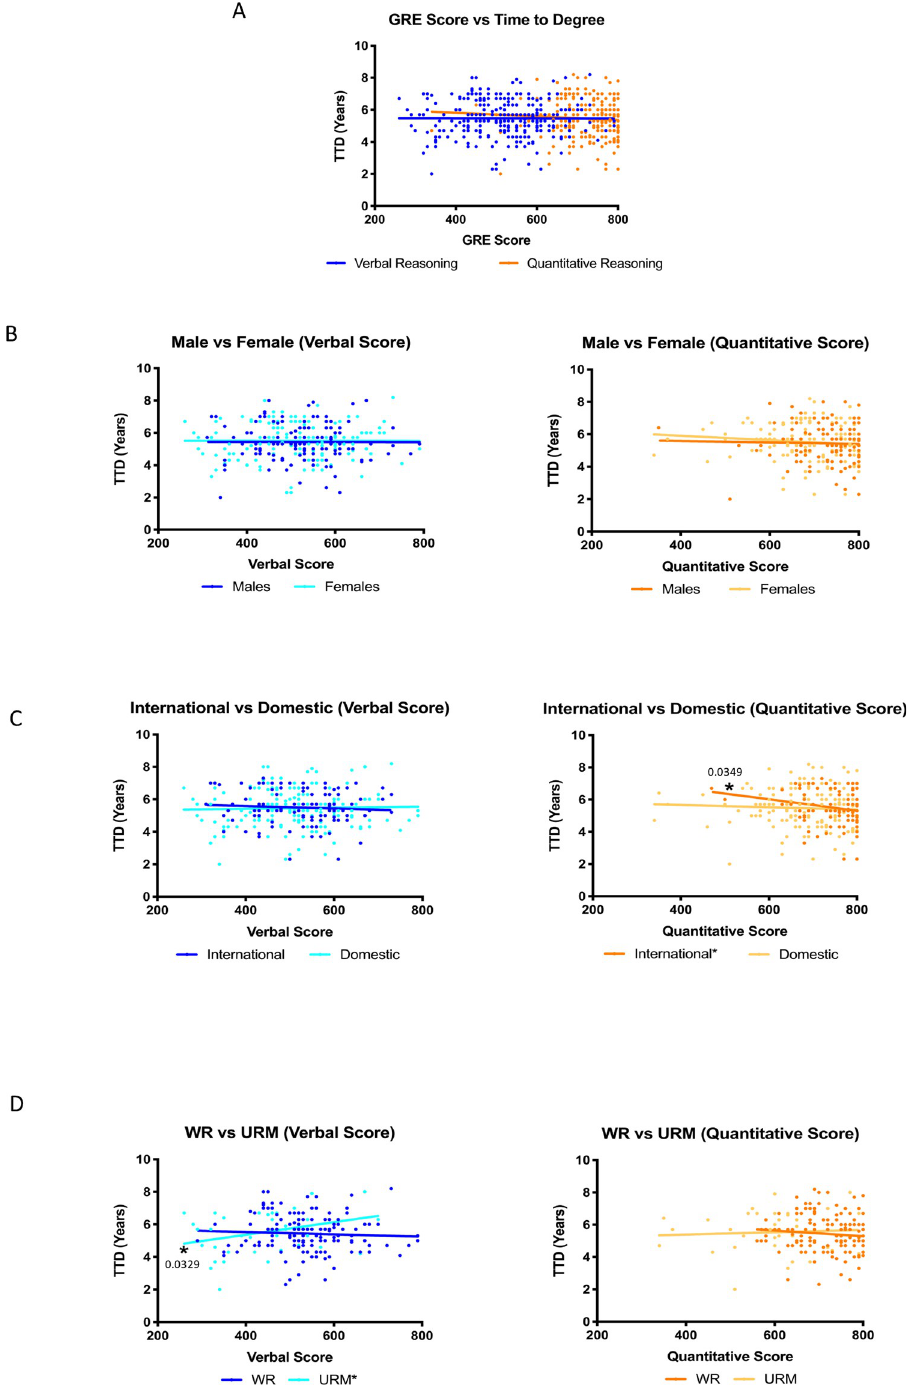
Fig 4. GRE scores are significantly correlated to the time it takes students to graduate with a PhD. Time to degree is plotted on a scatterplot as a function of GRE score (A). The data was further divided on a basis of gender (B), citizenship (C), and representation